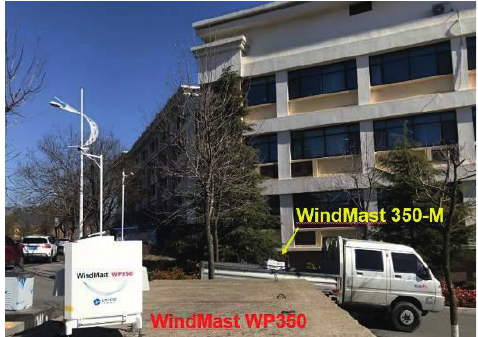
Figure 3. Comparison Experiment between WindMast 350-M and WindMast WP350